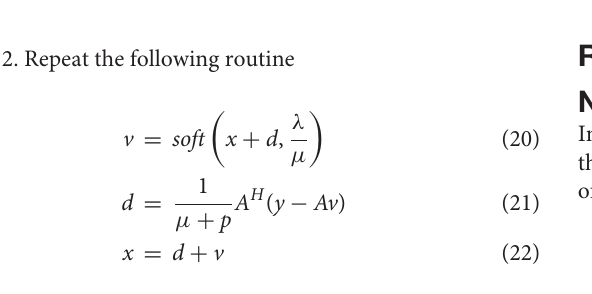
FIGURE 2 | (A) Time domain waveform of the simulated signal; (B) FFT spectrum of the simulated signal; (C) zoom-in plot of the FFT spectrum; and (D) linear combination coefficients of the redundant Fourier